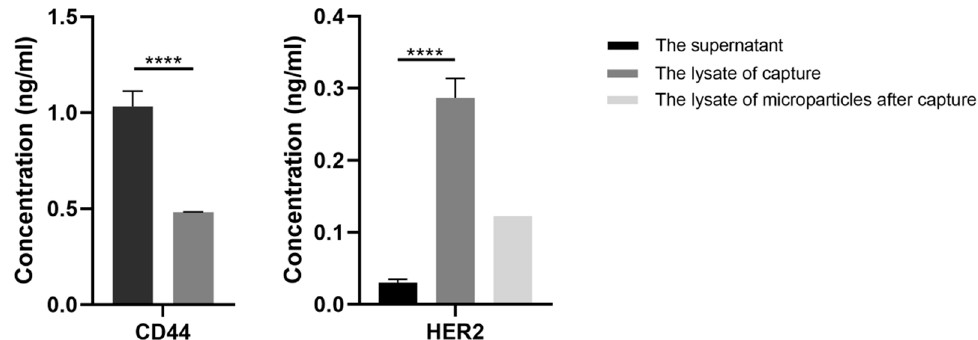
Figure 6. The ELISA results for CD44 and HER2 after immunoaffinity capture of EVs using HER2 antibody-coated microparticles in the supernatant and the lysate of the microparticles. For the EVs of MDA-MB-231, the concentrations of CD44 in the lysate of HER2 antibody-coated microparticles and the supernatant were tested. For the EVs of BT474, the concentrations of HER2 were tested. Additionally, the normalized concentration of the collected samples after EV-microparticle conjugate isolation is shown in the lightest gray column. **** P < 0.0001.